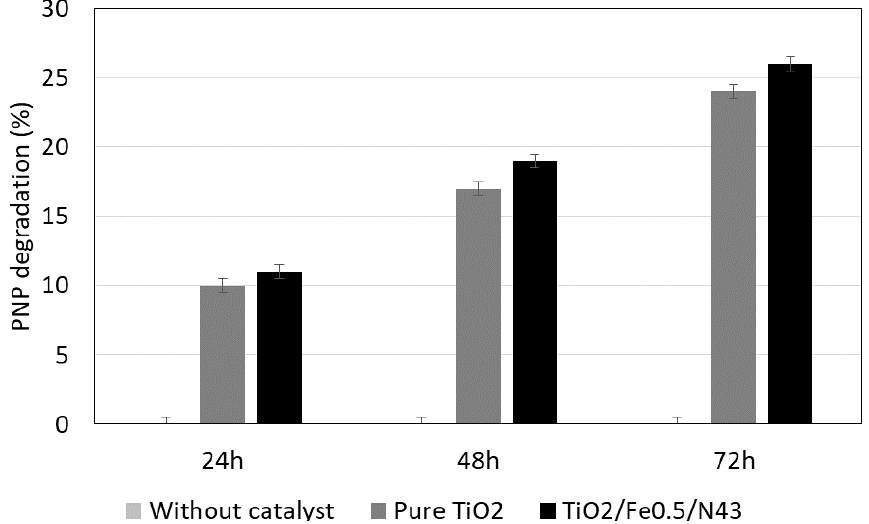
Figure 8. p -Nitrophenol (PNP) degradation (%) for pure TiO 2 and TiO 2 / Fe0.5 / N43 films under UV-A light ( λ = 365 nm) after 24–48–72 h of illumination. No degradation took place without catalyst (error bars still shown).